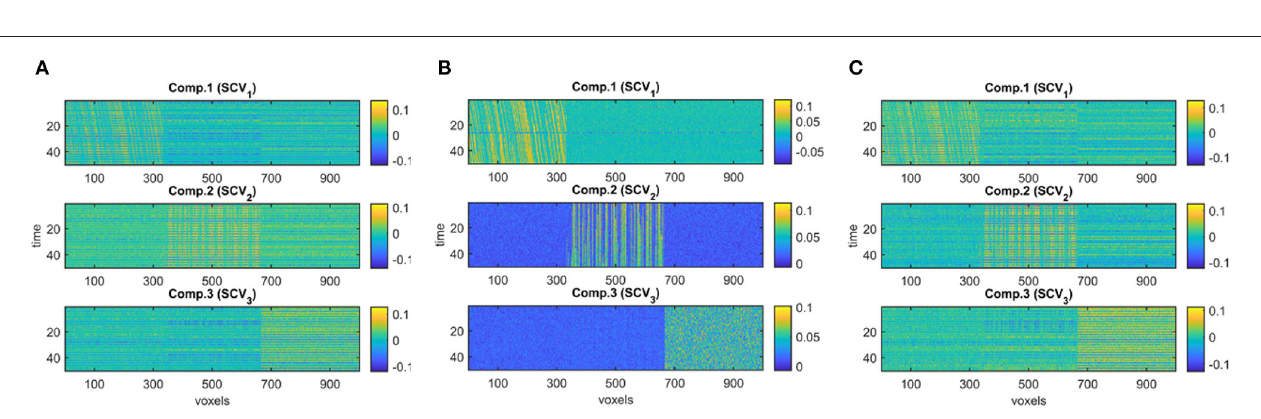
FIGURE 7 | Case 2. Evolving components ( B k or S k , for k = 1,..., K ) captured by each method: (A) PARAFAC2, (B) IVA, (C) joint ICA. PARAFAC2 and joint ICA fail to capture the underlying networks while IVA can reveal the evolving components